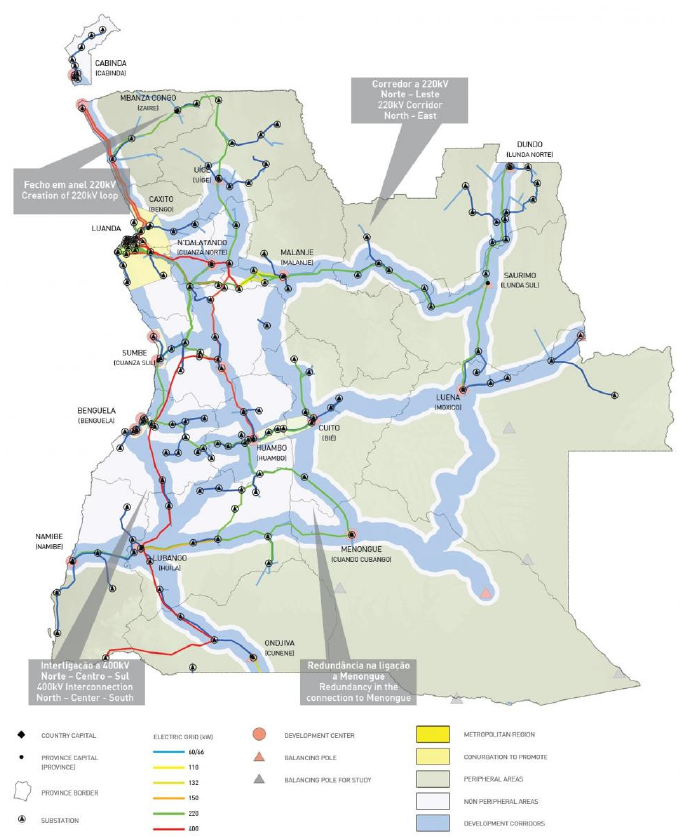
Figure 4. Industrial development axes in Angola. Source: Instituto Cartográfico de Angola (2020).